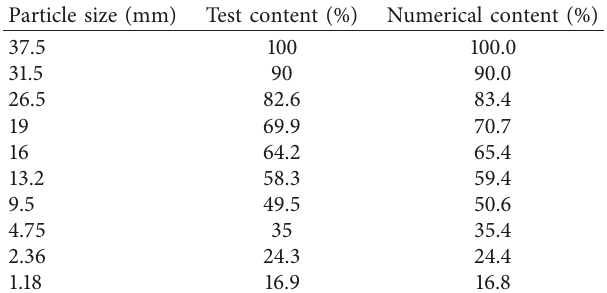
Table 1: Particle size distributions of the graded aggregate. Particle size (mm)